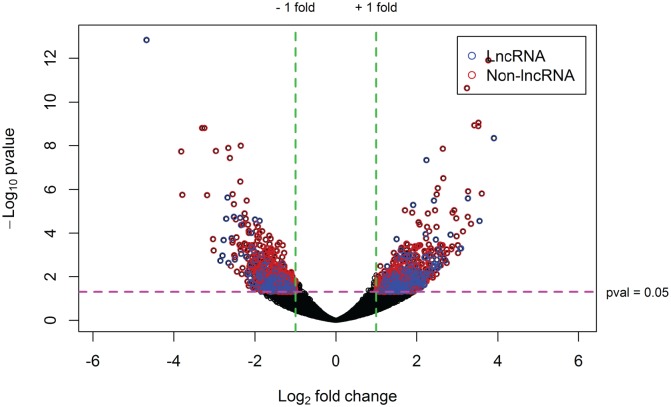
Differentially expressed genes in the ASD cortex.The volcano plot displays genes differentially expressed in the ASD cortex. A gene was required to have an absolute value of log2 fold change greater than or equal to one and an adjusted p-value less than 0.05 to be considered differentially expressed.